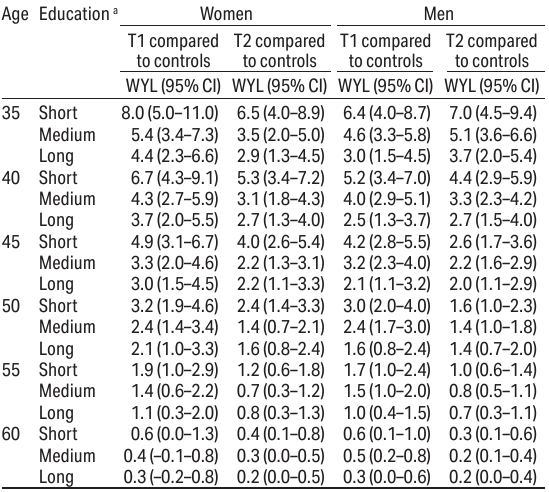
Table 3b. Working years lost (WYL) in years and 95% confidence in - tervals (CI) of participants living alone with type 1 (T1) and type 2 (T2) diabetes compared to those without by sex, age and